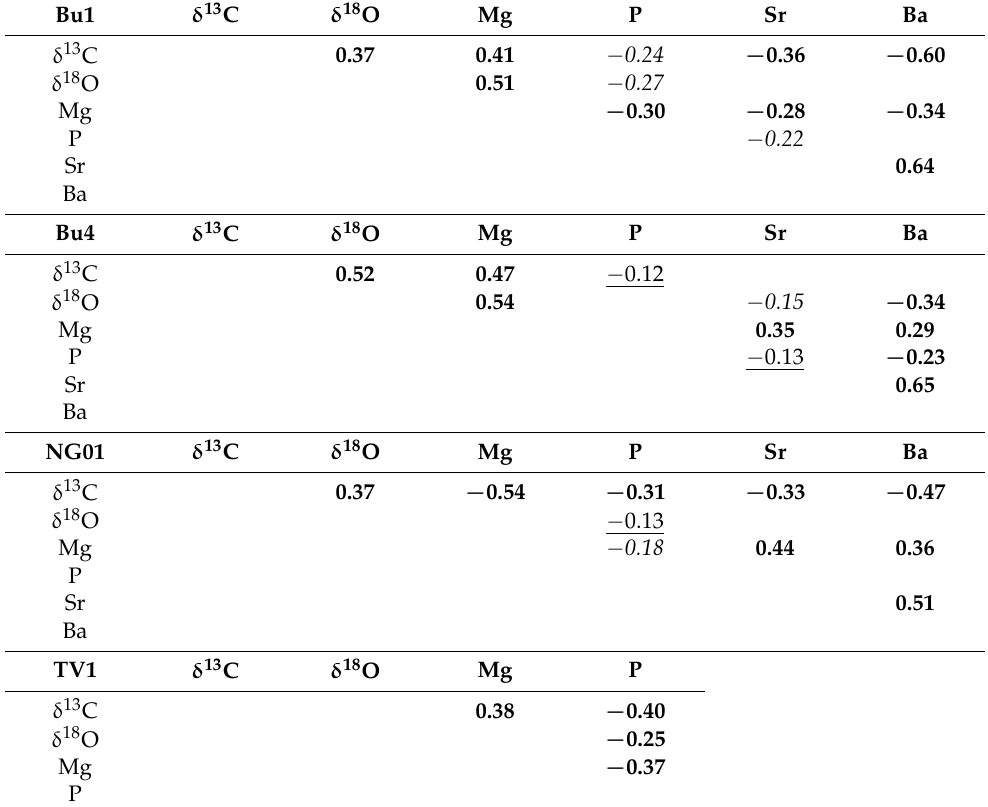
Table 3. Correlation coefficients of the stable isotope and trace element data of all four speleothems. Only significant correlations are shown. Numbers in bold indicate p values < 0.001, numbers in italics p values < 0.01 and underlined numbers p values <